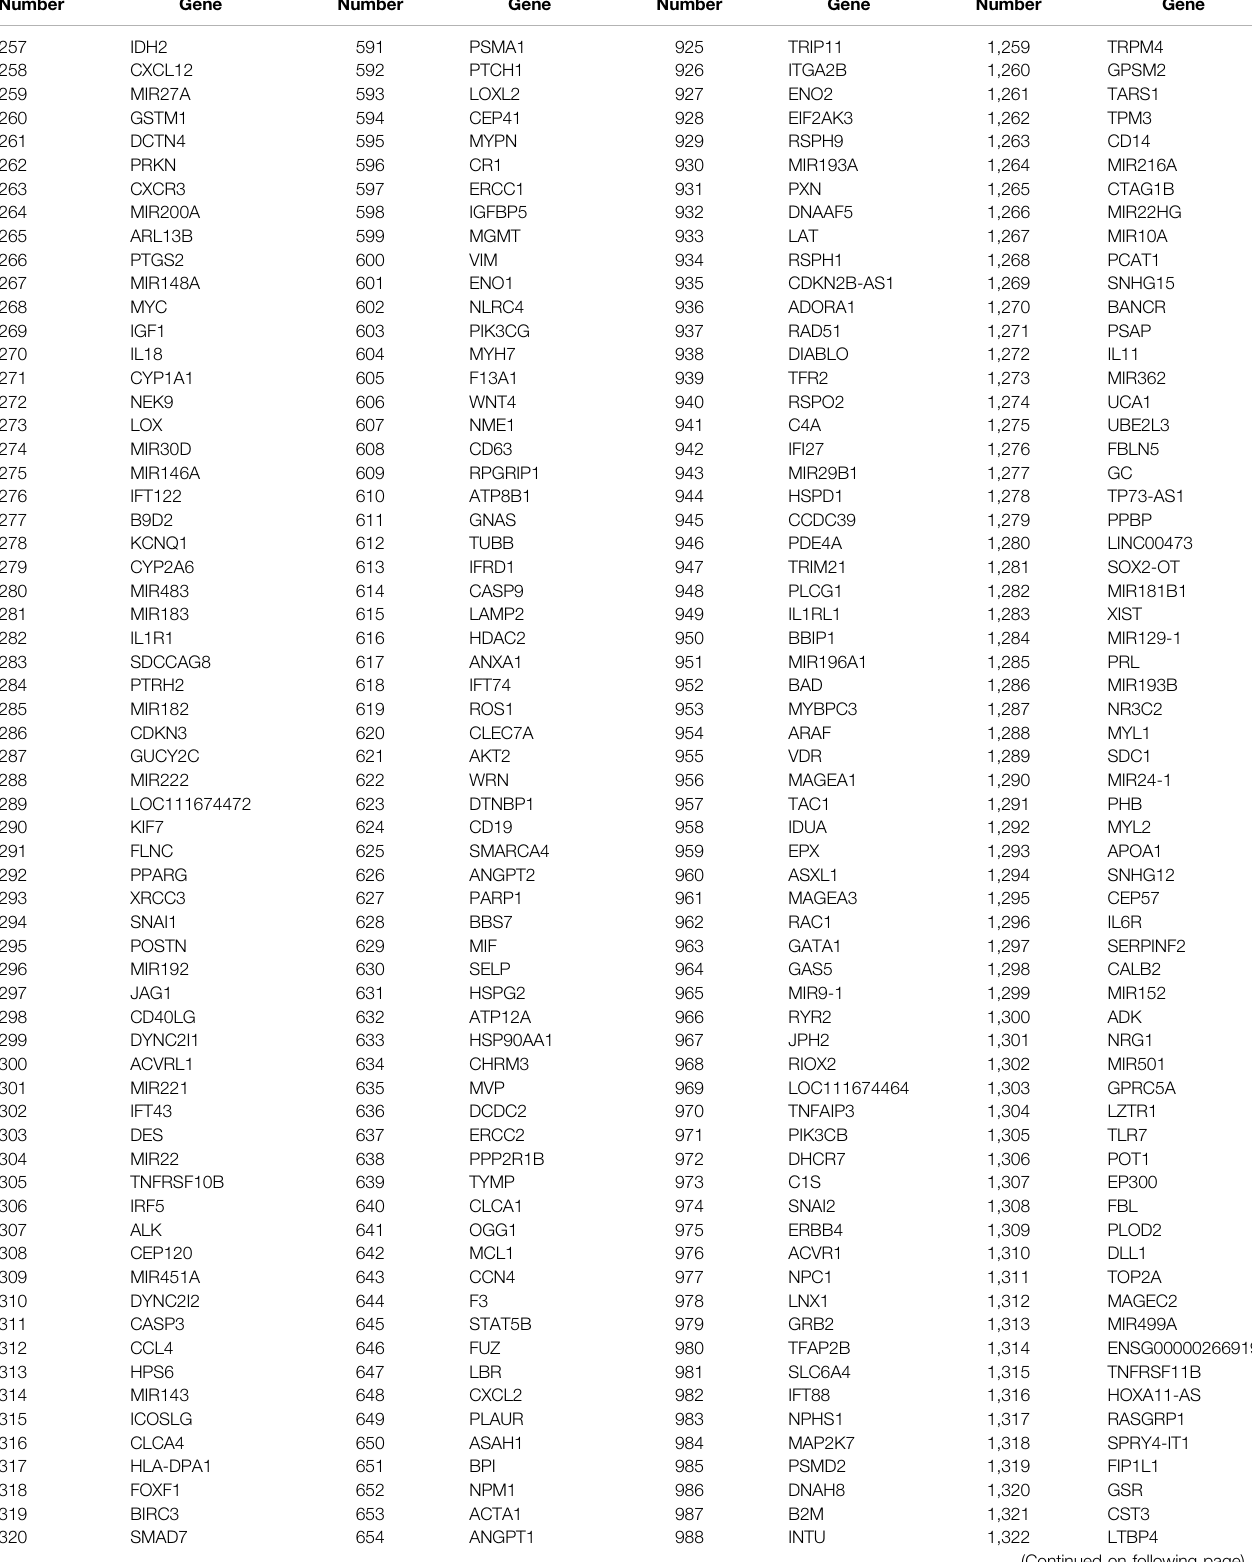
TABLE 3 | ( Continued ) Lung fi brosis-related targets obtained from the GeneCards